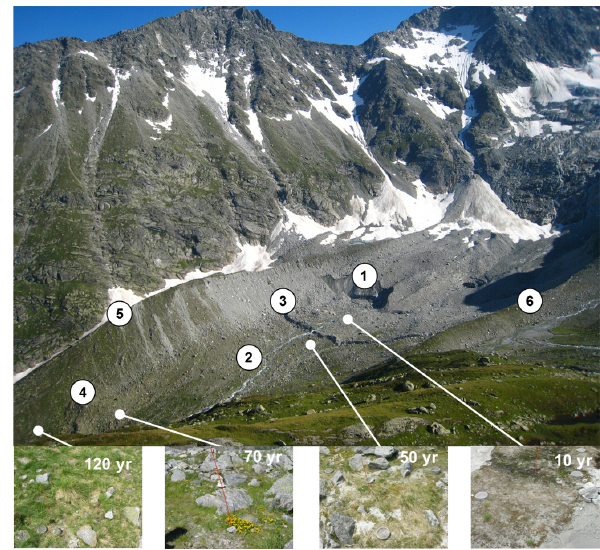
Fig. 1. The forefield of the Damma Glacier (Switzerland) as it devel- oped in response to the continuous retreat of the glacier. The num- bers mark important corner points of the forefield: (1) the glacier terminus, (2) the glacier stream, (3) moraine from 1992, (4) moraine from 1928, (5) the south flanking moraine and (6) the north flank- ing moraine, which both date back to the end of the Little Ice Age in 1850. The small pictures are closeups from 10, 50, 70 and 120yr ice-free soils, where the 10yr site is situated in the initial part of the glacier forefield (6–13yr), 50 and 70yr sites in the intermediately developed sites (50–80yr) and the 120yr site in the most developed part of the forefield (110–160yr). Photos: A.